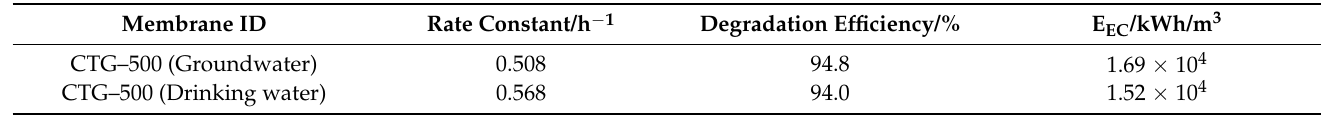
Figure 9. ( a ) Simultaneous filtration and photodegradation of KP (10 ppm, pH 5 for 5 h) in different water grades using CTG—500 membrane and ( b ) their reaction kinetics. Table 4. Rate constants and energy consumption of the filtration process.